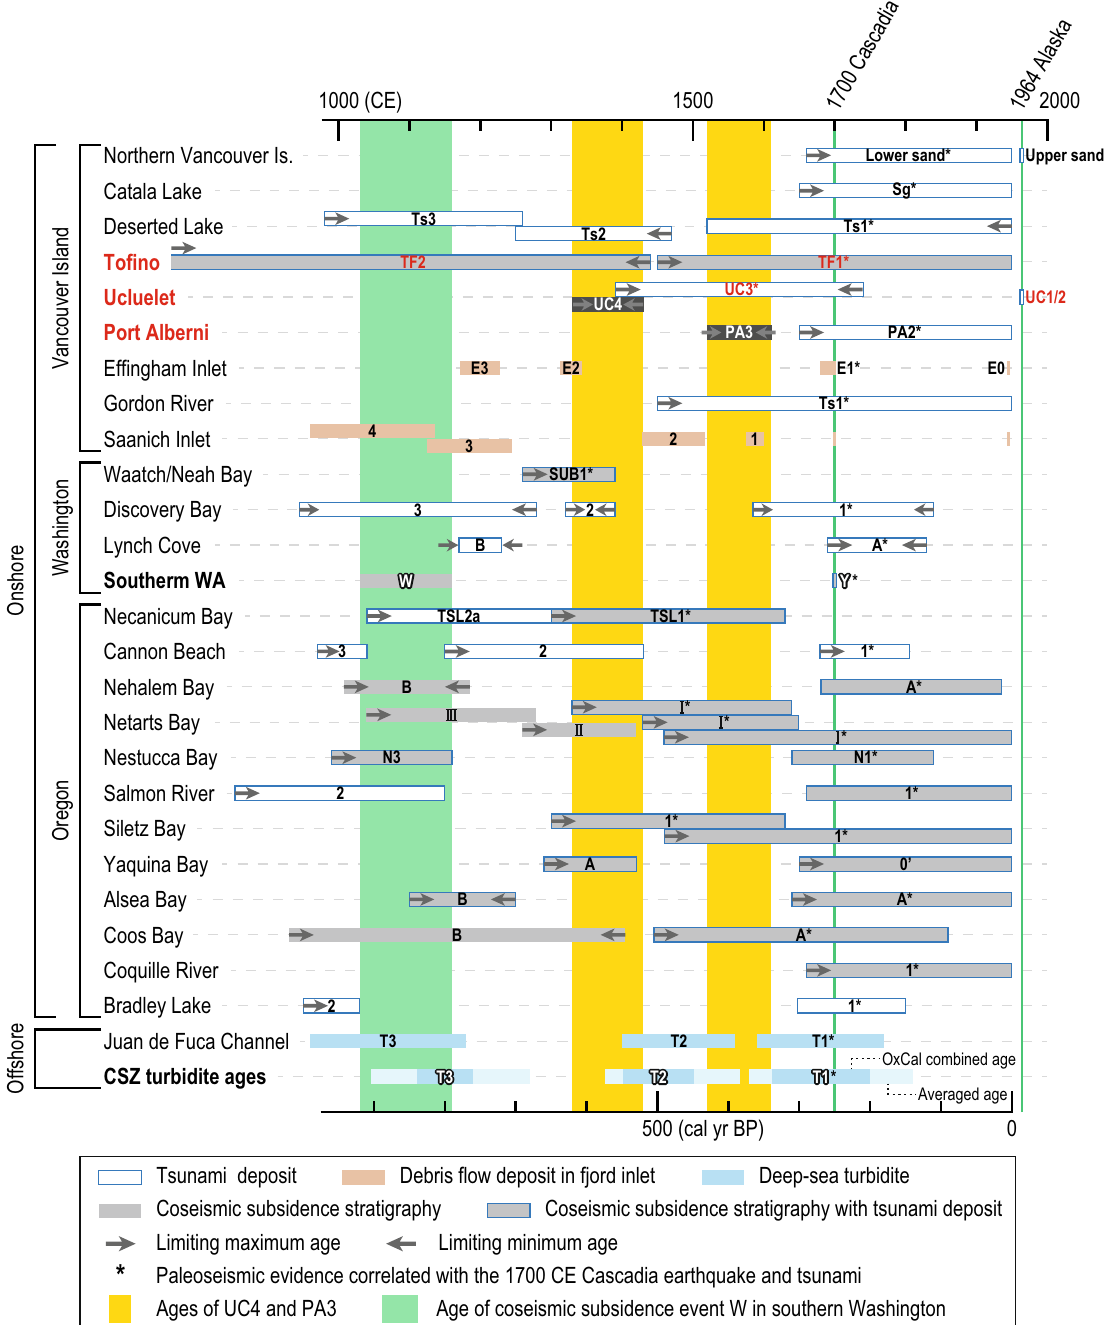
Figure 4. Comparison of age estimates for paleoseismic evidence along the Cascadia subduction zone over the past 1000 years: Locations listed from north to south—Northern Vancouver Island 27,33 (Koprino Habour, Neroutsos Inlet, and Fair Harbour), Catala Lake 34 , Deserted Lake 27,35 , Gordon River 27 , Effingham Inlet 30,45 , Saanich Inlet 74,75 , Waatch/Neah Bay 46 , Discovery Bay and Lynch Cove 43,44 , Southern Washington 9,28 (Copalis River, Grays Harbor, Willapa Bay, and Columbia River), Necanicum River 48,51 , Cannon Beach 47 , Nehalem Bay 48,51,76 , Netarts Bay 48,77 , Nestucca Bay 78 , Salomon River 15 , Siletz Bay 48,52 , Yaquina Bay 49,79,80 , Alsea Bay 10 , Coos Bay 50 , Coquille River 20 , Bradley Lake 81 , Juan de Fuca channel, and CSZ averaged turbidite ages 18 (locations shown in Fig. 1a) Referenced data are compiled in Table S2. Data from California are not included because there is no paleoseismic evidence correlated with UC4 and